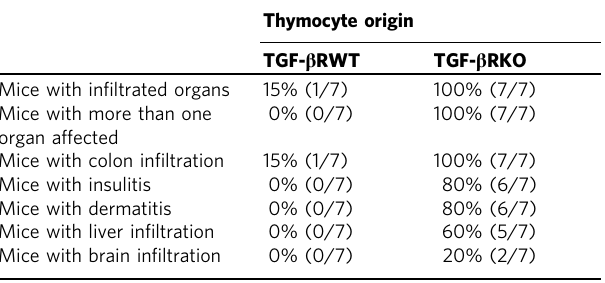
Table 1 Frequency of the observed